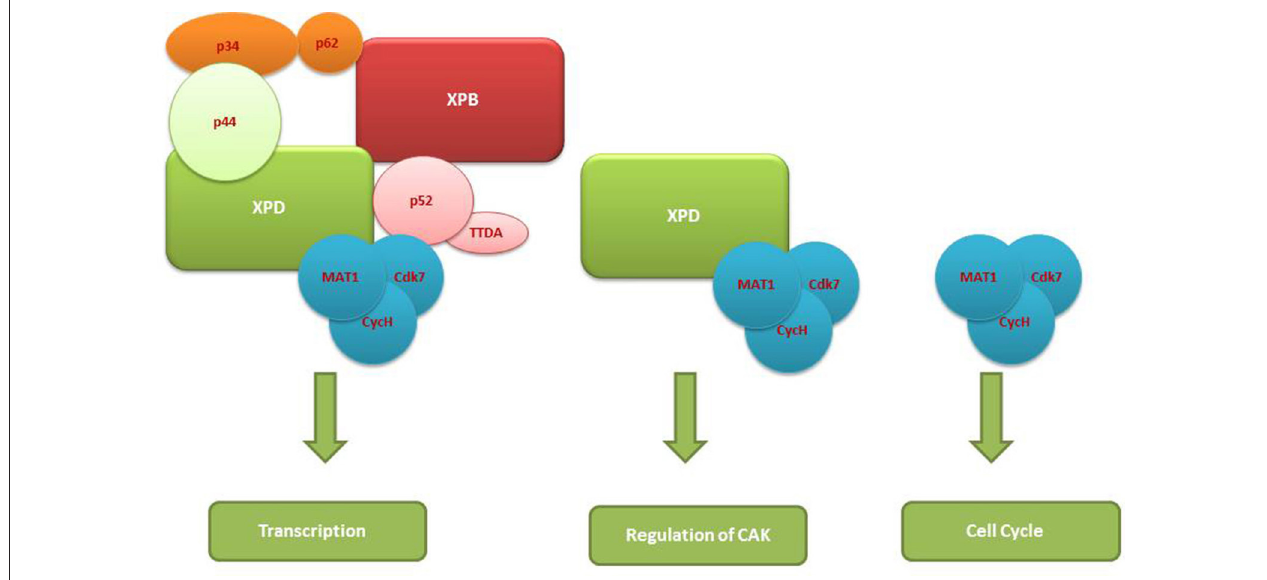
FIGURE 2 | TFIIH complexes vs. non-TFIIH complexes and differences in their